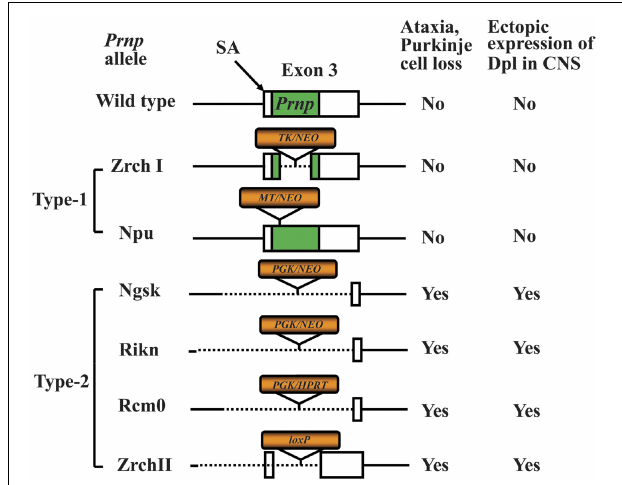
FIGURE 1 | Knockout constructs of type-1 and type-2 of prion protein gene ( Prnp )-knockout ( Prnp − / − ) mice. Structures of the constructs used to produce six lines of Prnp − / − mice. The Prnp − / − mice are divided into type-1 and type-2 Prnp − / − mice depending on whether the splicing acceptor of exon 3 is disrupted. The disruption of exon 3 is correlated with the development of late-onset ataxia and Purkinje cell loss, which is induced by ectopic expression of Doppel (Dpl) in the central nervous system (CNS). The structure of wild-type (WT) Prnp exon 3 and prion protein (PrP) coding region (green box) is shown at the top. The selection markers are indicated by orange boxes. The presence and absence of the exon 3 splicing acceptor (SA) is correlated with the development of late-onset ataxia. The selection markers were PGK, mouse phosphoglycerate kinase promoter; NEO, neomycin phosphotransferase; HPRT, mouse hypoxanthine phosphoribosyltransferase; TK, human herpes simplex virus type 1 thymidine kinase promoter; MT, mouse metallothionein promoter; loxP, a 34-bp recombination site from phage